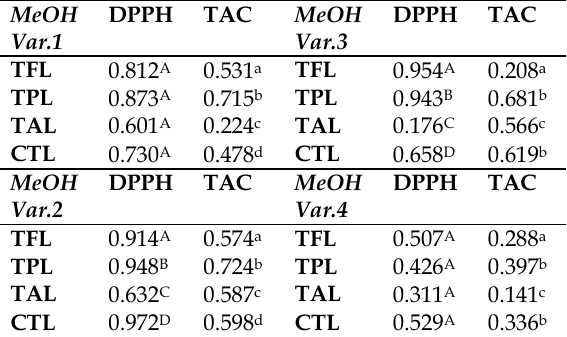
Table 2. The correlation coefficient among antioxidant capacity tests, total flavonoid level, total anthocyanins level, total phenolic level, and tannins